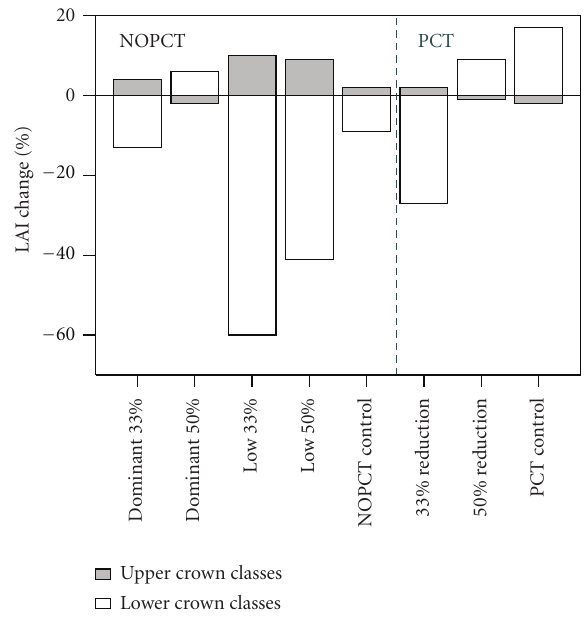
Figure 3: Direction and magnitude of leaf area change by crown classes (upper and lower) for the commercial thinning types (dominant, low) and reduction levels (33% and 50%) implemented by the Cooperative Forestry Research Unit Commercial Thinning Research Network. Note. PCT—precommercial thinning history, NOPCT—no history of precommercial thinning. Crown thinning canopy level information was not